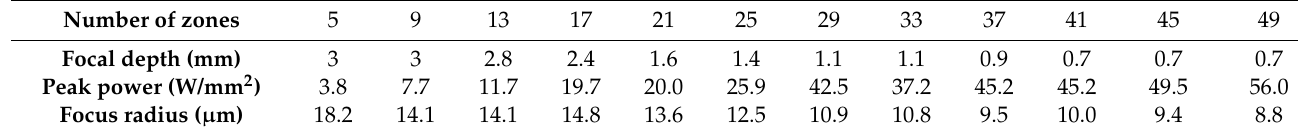
Table 1. Comparison of diffraction properties of S-FZPs with different zone numbers.